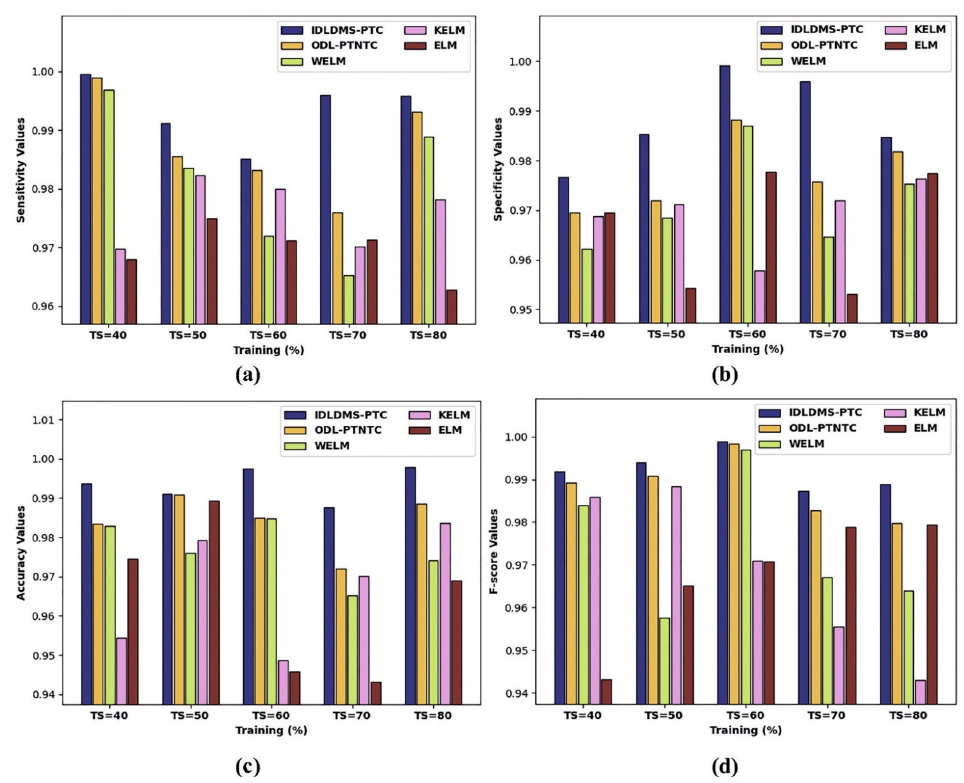
trayed in Figure 4. The results demonstrated that the IDLDMS-PTC technique accom- Figure 3. Result analysis of IDLDMS-PTC technique under different sizes of training set: ( a ) sensitivity, ( b ) specificity, ( c ) accuracy, and ( d ) F-score. Table 1. Results analysis of IDLDMS-PTC technique under different sizes of training set with exist- ing approaches.